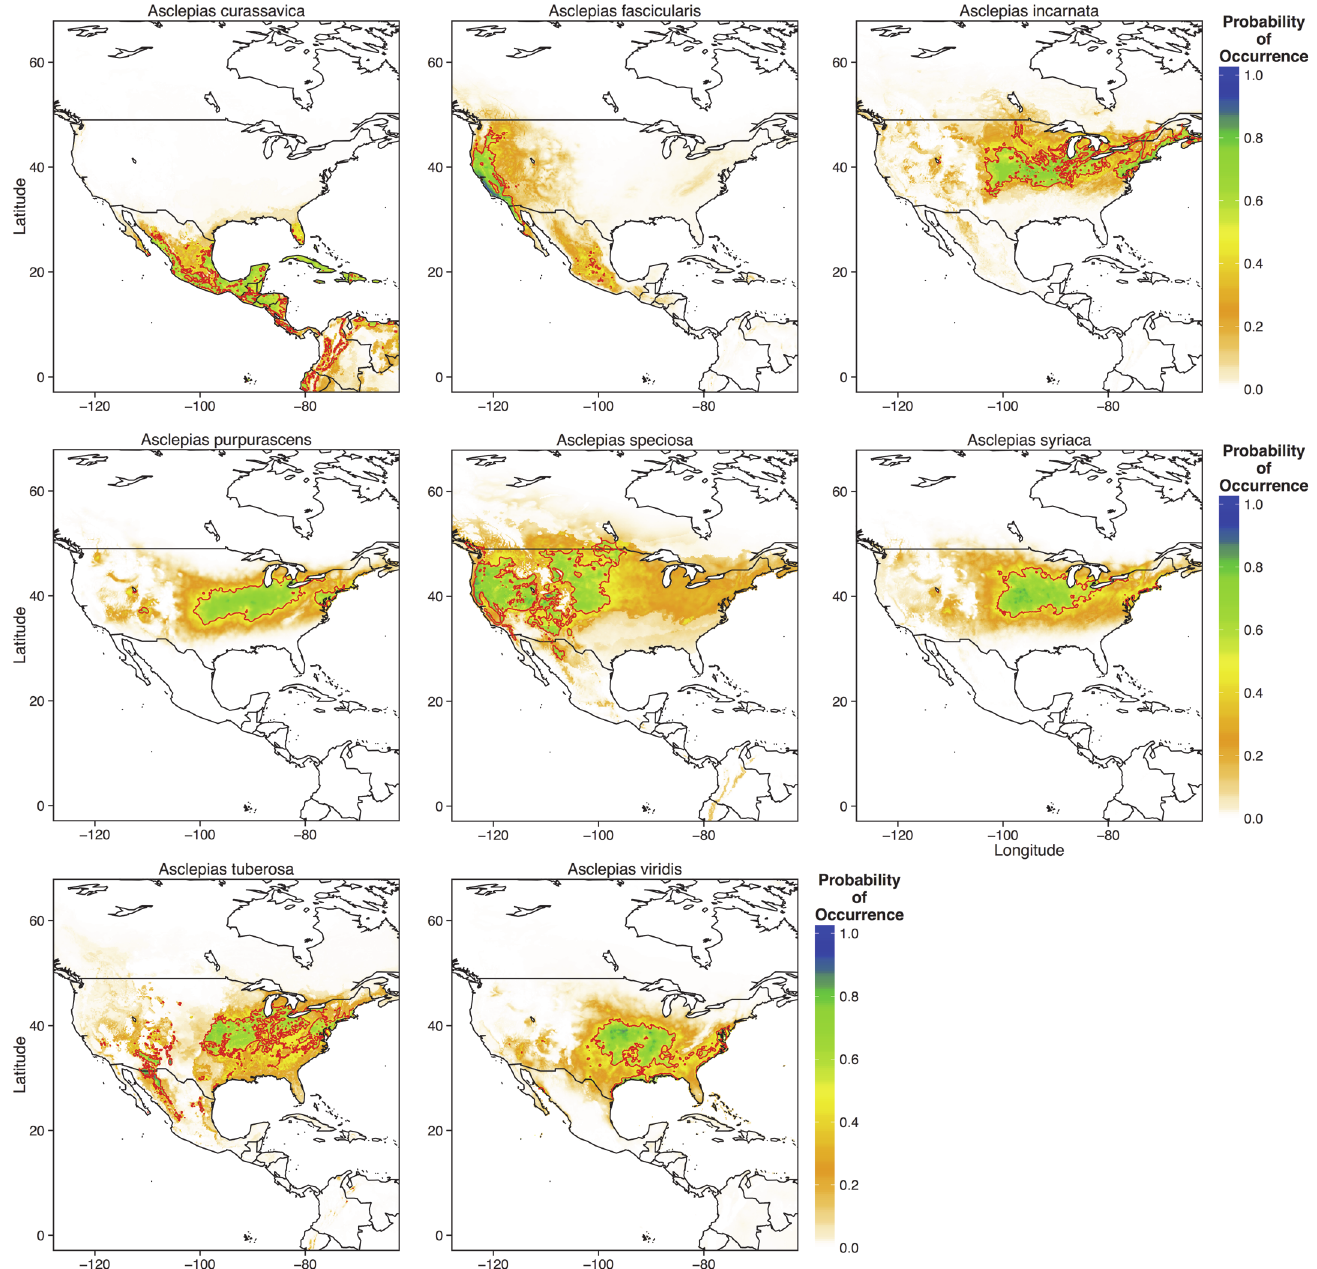
Fig 3. Predictions for the probability of occurrence of each of the eight Asclepias species across North, Central, and parts of South America. Thick red lines denote the 0.5 probability contour, such that areas inside the contour have a (cid:1) 0.5 probability of containing Asclepias or the individual